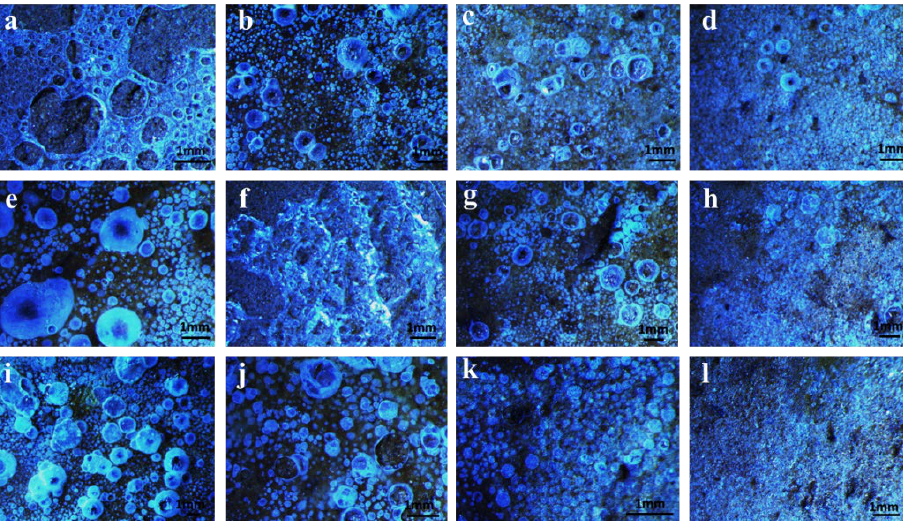
Figure 4. Surface morphology of consolidated adhesive film. ( a – d ) Preparation conditions of KGM/CA/PVA ternary blend adhesive: the preparation temperature was 50 °C; The contents of CA were 1%, 2%, 2.5%, 3%, respectively; ( e – h ) Preparation conditions of KGM/CA/PVA ternary blend adhesive: the preparation temperature was 60 °C; The contents of CA were 1%, 2%, 2.5%, 3%, respectively; ( i – l ) Preparation conditions of KGM/CA/PVA ternary blend adhesive: the preparation temperature was 70 °C; The contents of CA were 1%, 2%, 2.5%, 3%, respectively. Other preparation conditions of ( a – l ) KGM, PVA content were 4.5% and 3%, respectively; The pH value of the ternary blend was 5.0; pH of cinnamon soil was 8.5; Particle size of soil was 1 mm.